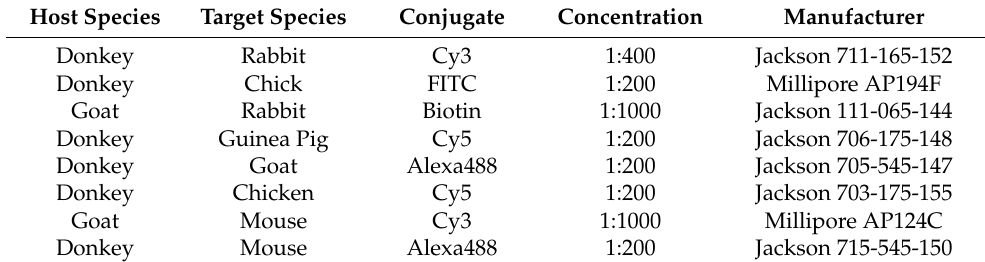
Table 2. Secondary